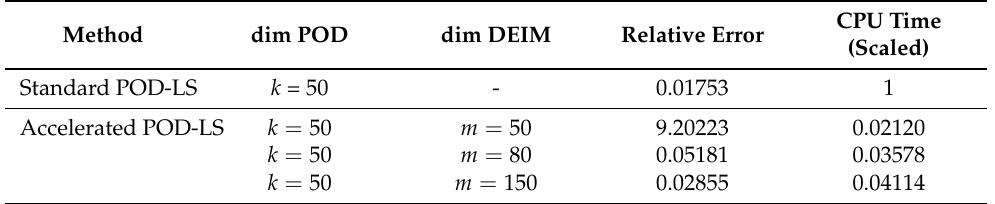
Table 2. (Numerical Test 2) The average relative error of the reconstructed missing data and the corresponding scaled CPU times for the reconstruction when the standard POD-LS method and the accelerated POD-LS method with rSVD are used. Dimensions for POD: k = 50, DEIM: m = 50,80,150.